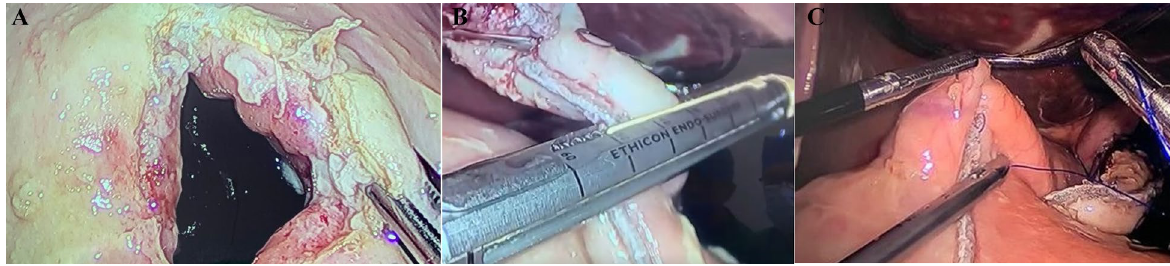
Fig. 2 A Gastric ulcer in the anterior wall of the stomach. B Mechanical Staplers removing the ulcer and closing the gastrostomy. C Staple line